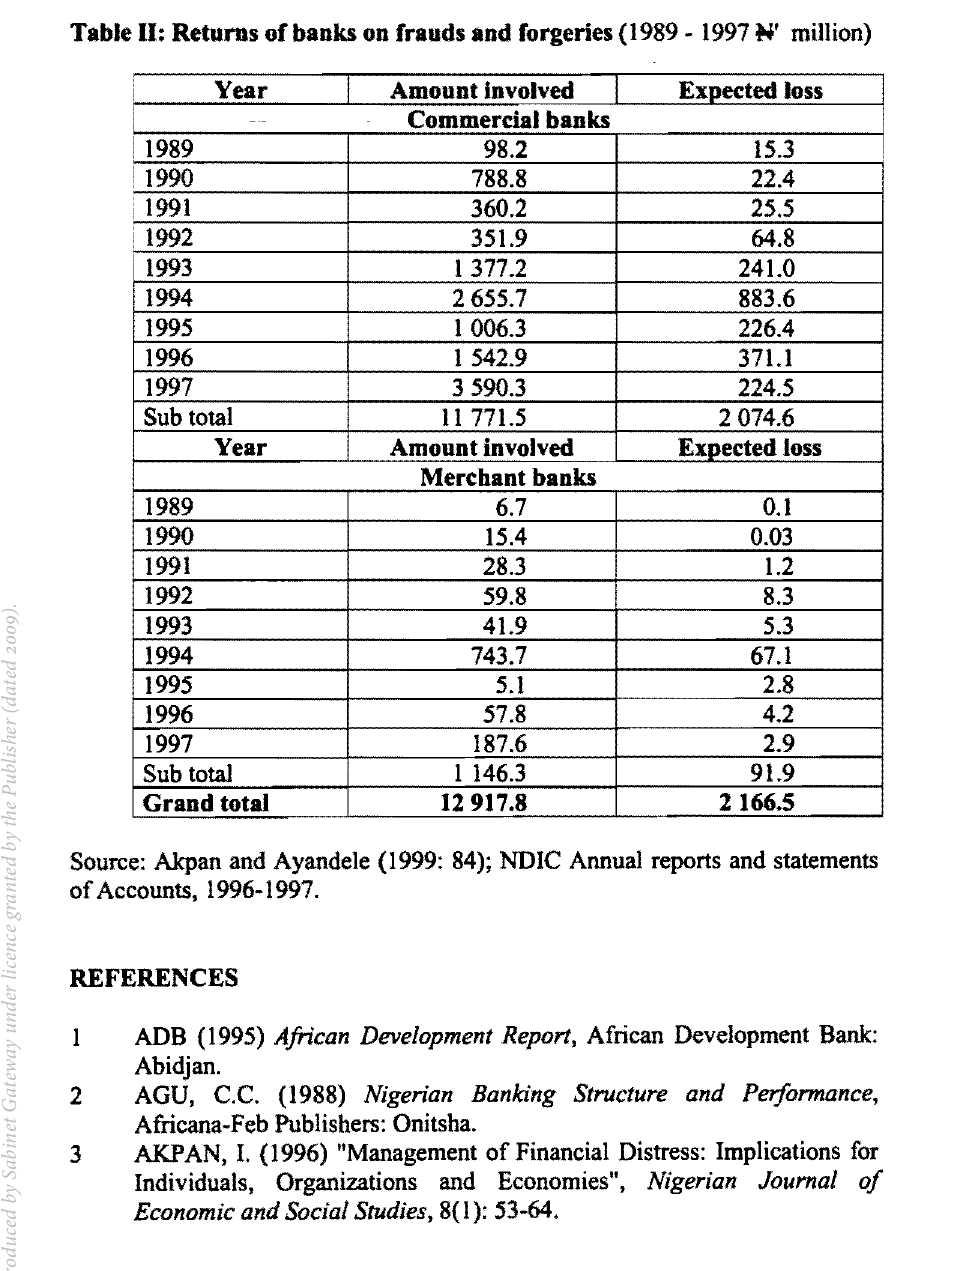
Table II: Returns of banks on frauds and forgeries (1989 - 1997 H'